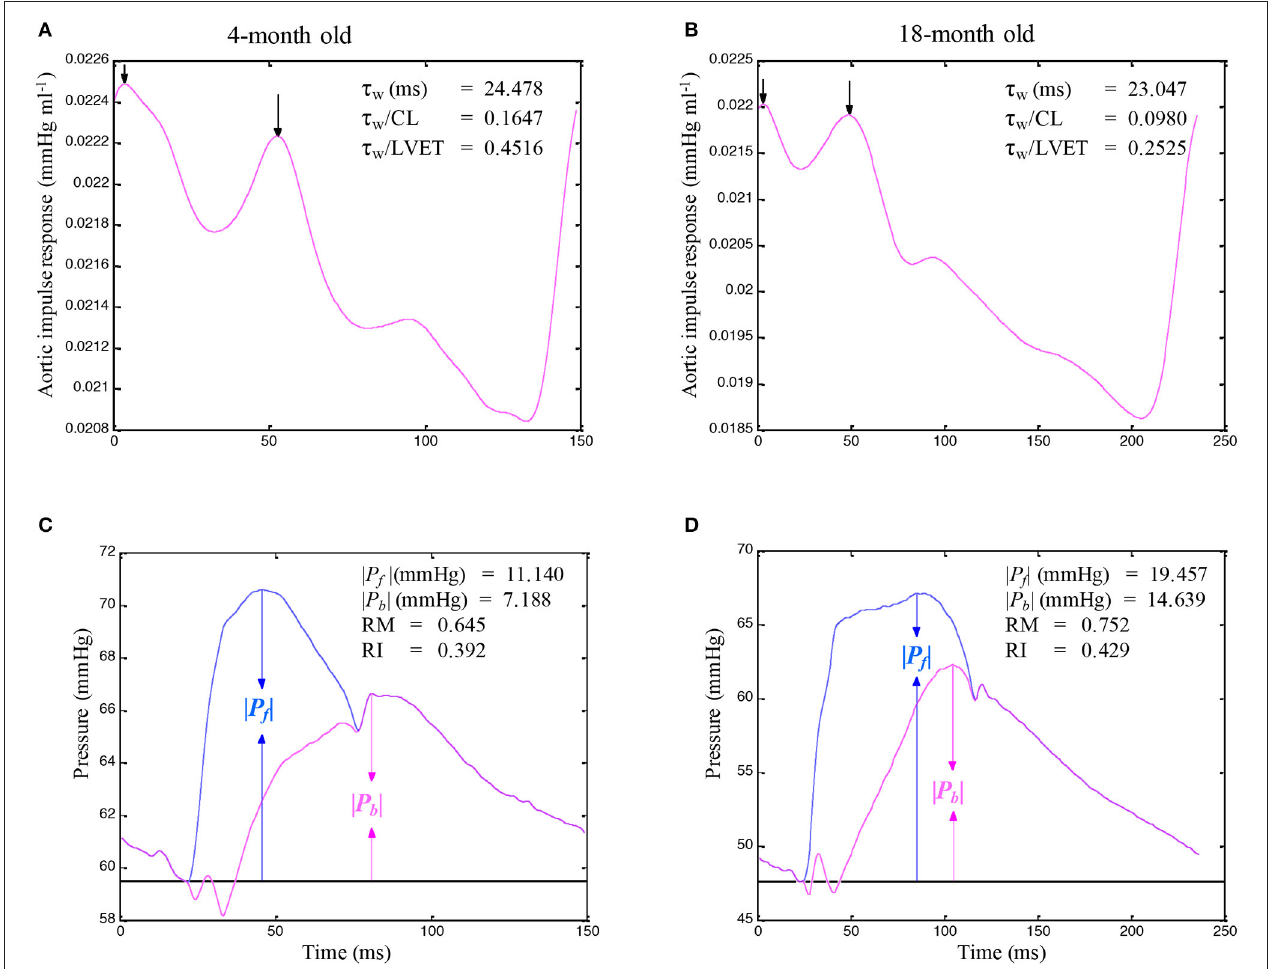
FIGURE 4 | Impulse response function curve obtained from the measured aortic pressure and an assumed triangular flow ( Q tri ) in the same rats aged 4 (A) and 18 (B) months, which are shown in Figure 3 . The P f and P b waves for the corresponding rats aged 4 (C) or 18 (D) months are also depicted. In C and D , the amplitudes (peak - trough) of the P f and P b are represented by | P b | and | P f | , respectively. CL, cardiac cycle length; LVET, left ventricular ejection time; P f , forward pressure wave; P b , backward pressure wave; RM, wave reflection magnitude, given by | P b | / | P f | ; RI, wave reflection index, given by | P b | /( | P f | + | P b | ); τ w , wave transit